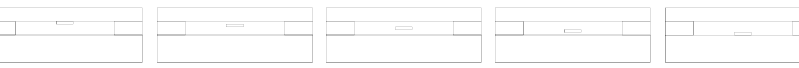
Figure 13. Depth of damages location.